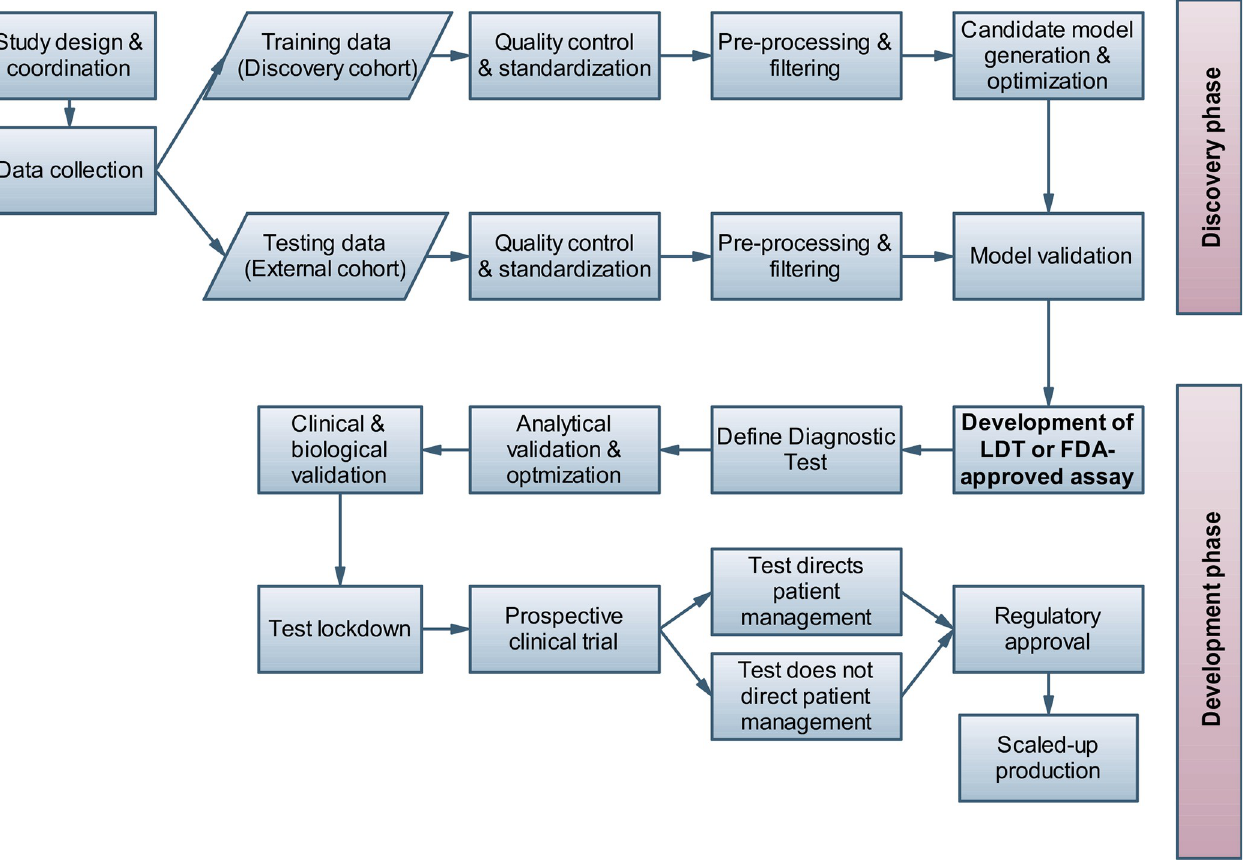
Fig 1. Schematic overview of key steps in a common biomarker test development workflow for patient stratification or disease outcome